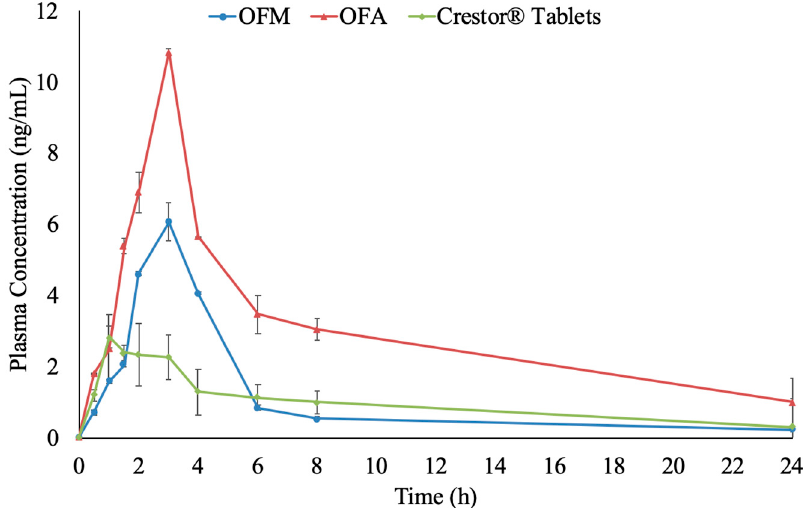
Figure 8. Plasma level-time curve of RC after a single oral dose of enteric-coated capsules filled with both optimized (OFM and OFA) formulations and the market product (Crestor ® Tablets).